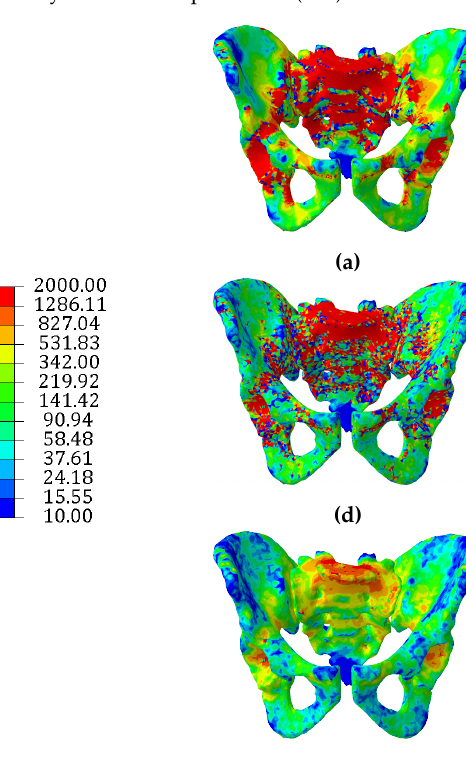
Figure 4. Distributions of cortical thickness (mm) for the hybrid isotropic model ( a – c ), hybrid orthotropic model ( d – f ) and structural model ( g – i ).